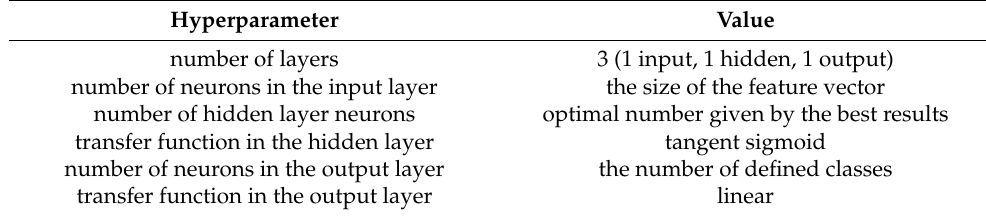
Table 3. Hyperparameters of the MLP structure.